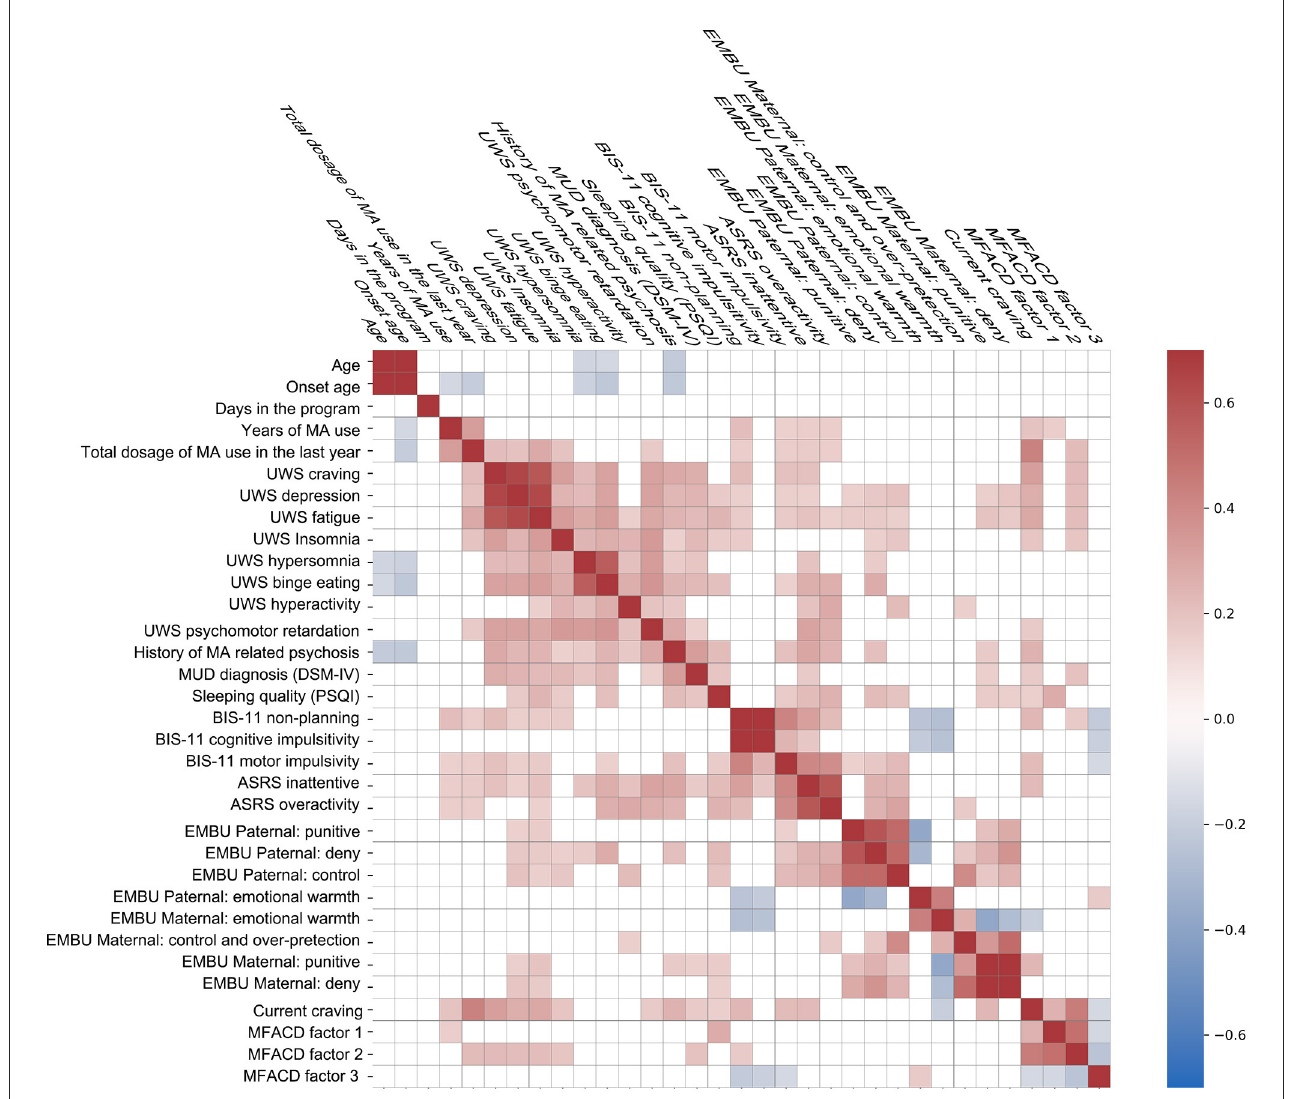
FIGURE3 Correlational map of the motivations, upbringing environment, impulsivity traits, and drug intoxication. UWS: unintended withdrawal symptoms. MUD: methamphetamine use disorders. BIS-11, Barratt Impulsiveness Scale = 11. MFACD, the motivation for/against change relating to compulsory detoxification. Pearson correlation coefficients > 0.15 (or < -0.15) were colored on the map.